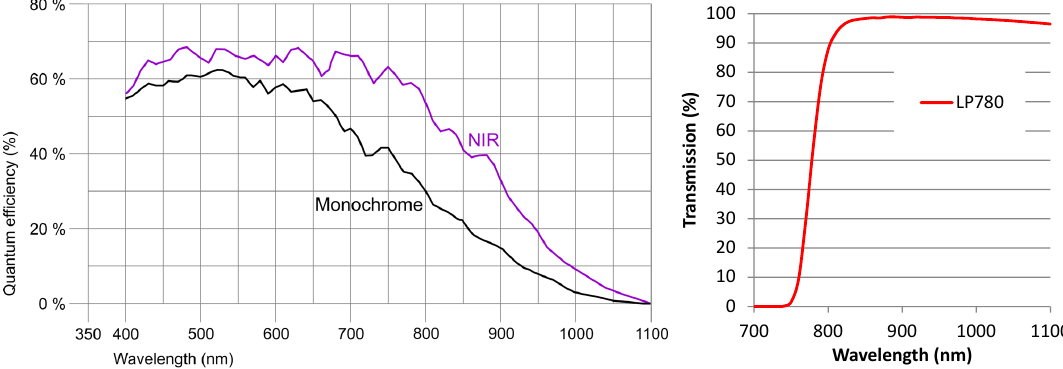
Figure 3. ( Left ) IDS UI-ML-3240-NIR quantum efficiency chart, ( right ) LP780 transmission chart.